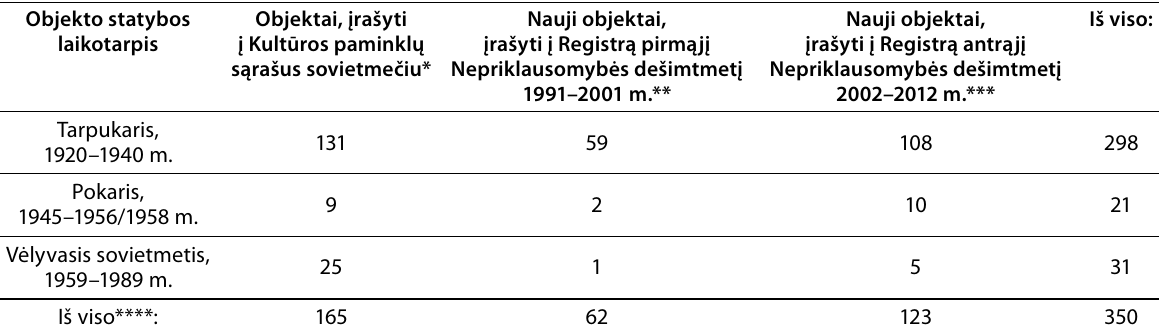
Table. lithuanian architectural heritage buildings and sites of 1920–1990 listed from the 1970s to 2012 (the table is formed according to the data published on the site of the Department of Cultural Heritage